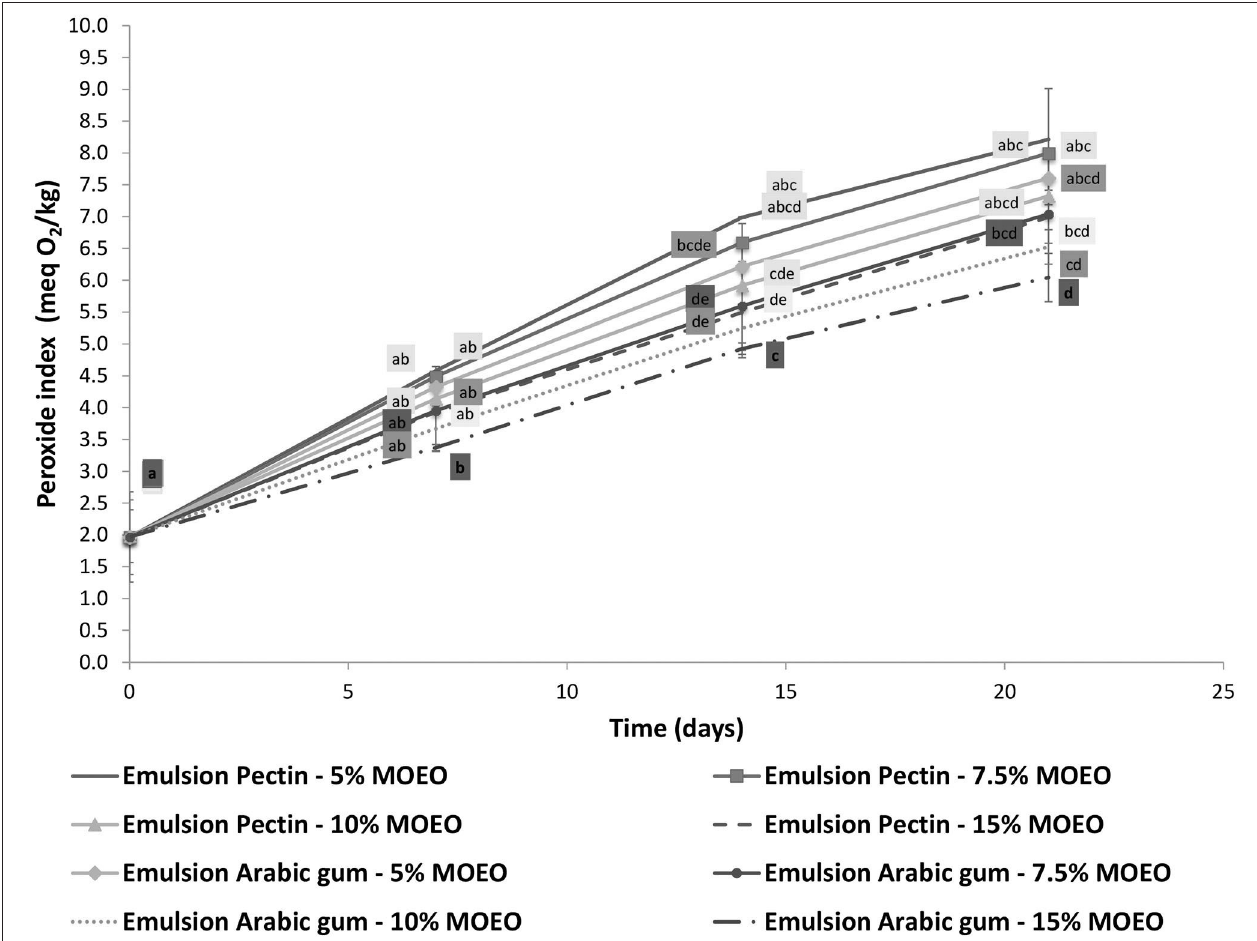
FIGURE 4 | Peroxide index of emulsions with pectin or Arabic gum at different concentrations of Mexican oregano essential oil (MOEO), stored at 25 ◦ C, during 21 days of observation. Systems that do not share the same letter at each time are significantly different ( p <